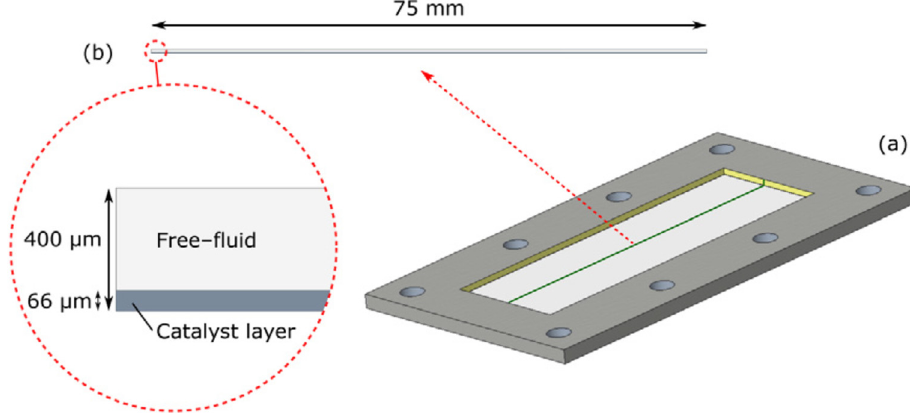
Figure 2. 3D schematic diagram of the plate microreactor ( a ) and distribution of fluid and catalyst ( b ) [19].